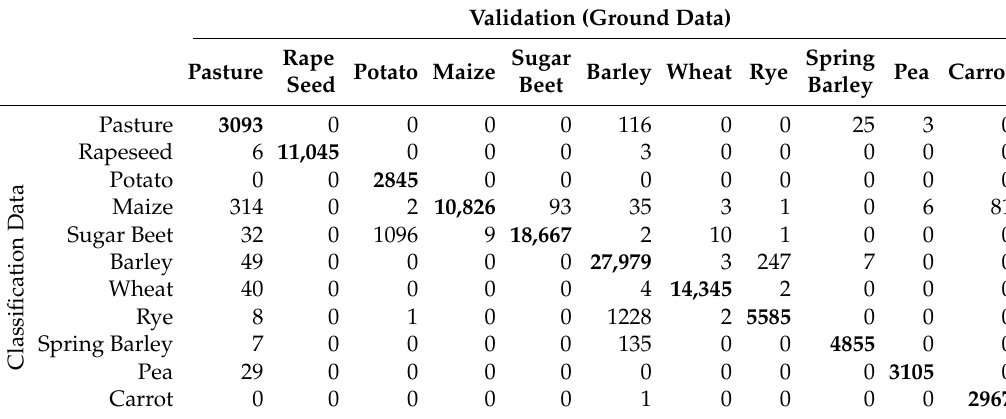
Table 4. Error Matrix of the proposed classification, shown in Figure 3. Validation (Ground Data)